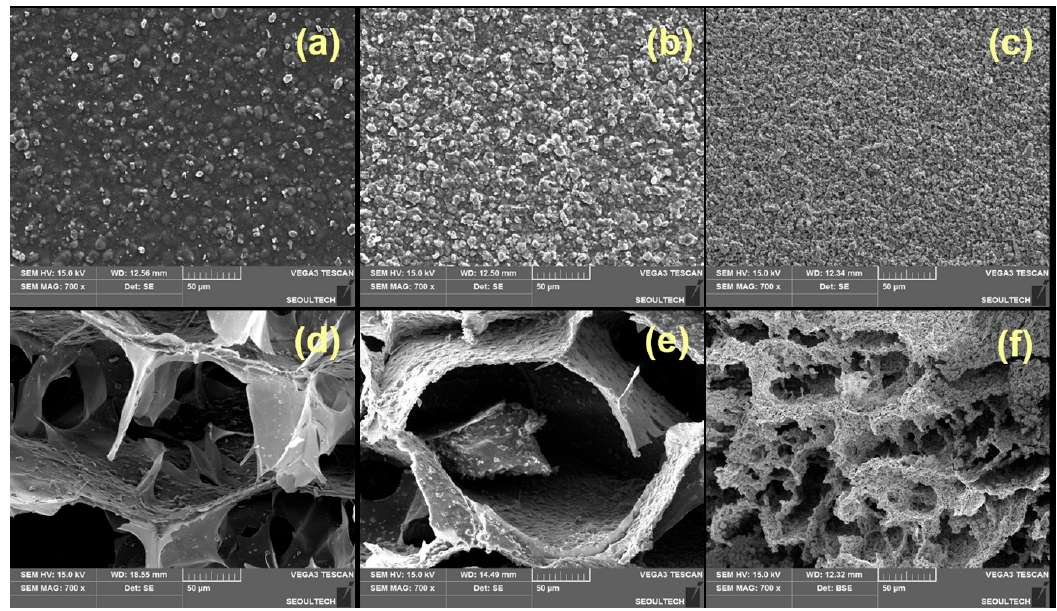
Figure 5. Surface ( a – c ) and cross-section images of dried Alg- α -TCP hybrid gels with